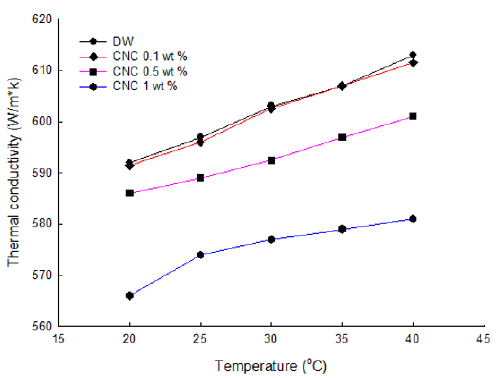
Figure 7. Thermal conductivity measurements of CNC according to concentration.